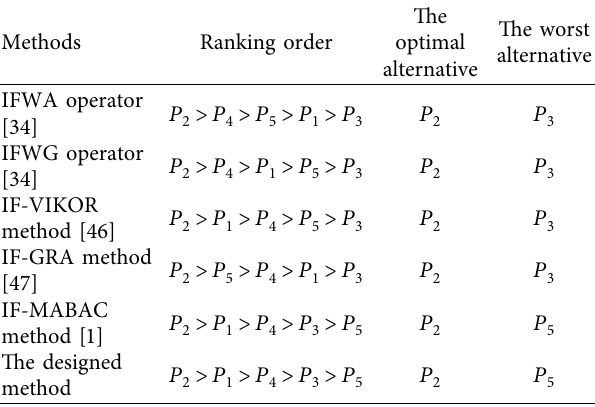
Table 13: Evaluation results of these